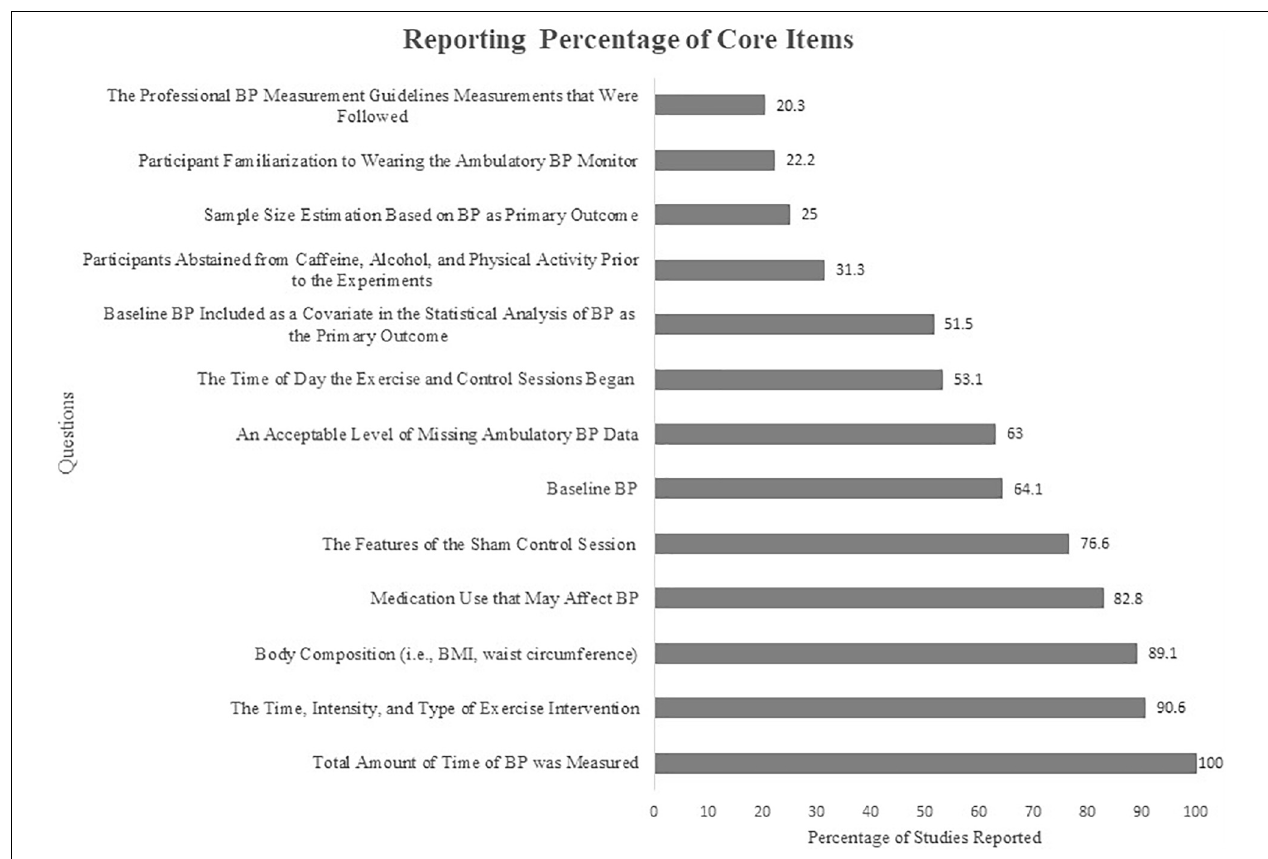
√ list core items. BP, blood pressure; BMI, body mass